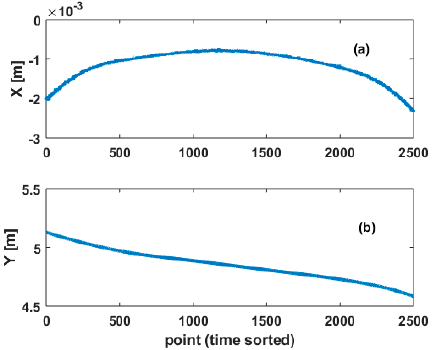
Figure 5. Simulated parametric B-splines curves. ( a ) X component; ( b ) Y component versus point number (i.e., time). To the geometrical observations is added a noise vector, with VCM Q 0 . This real case study corresponds to an arch bridge with a known noise vector.